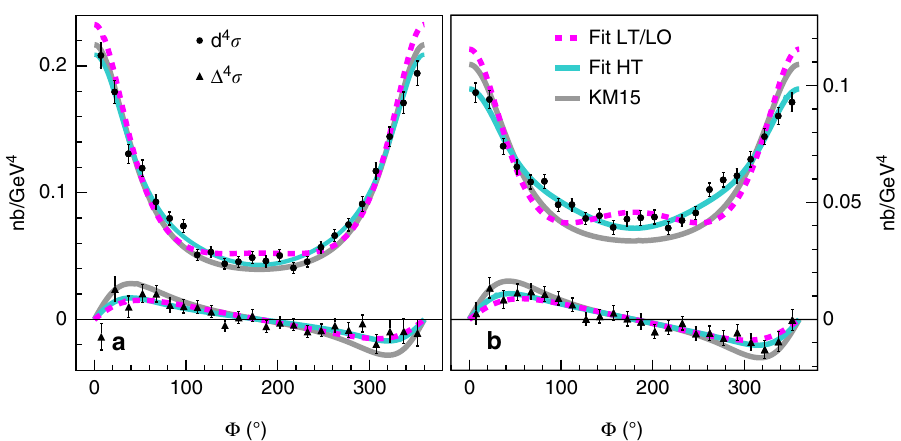
Fig. 4 Beam helicity-dependent and helicity-independent cross sections. Unpolarized cross sections are represented with black circles and polarized cross sections with black triangles. The kinematic setting shown corresponds to Q 2 = 1.75 GeV 2 , x B = 0.36, and t = − 0.30 GeV 2 . The beam energies are E beam = 4.455 GeV ( a ) and E beam = 5.55GeV ( b ). Bars show s.d. statistical uncertainties, calculated as the squared root of the number of detected events and propagated to the measured cross sections. Dashed lines represent the result of the LT/LO fi t with H þþ , E þþ , ~ H þþ , and ~ E þþ . Solid lines show the result of the HT fi t with H þþ , ~ H þþ , H 0 þ , and ~ H 0 þ . Curves for the NLO fi t ( H þþ , ~ H þþ , H (cid:3)þ , and ~ H (cid:3)þ ) overlap with the HT fi t and are not shown. Results of the KM15 29 fi t to previously published DVCS data are also